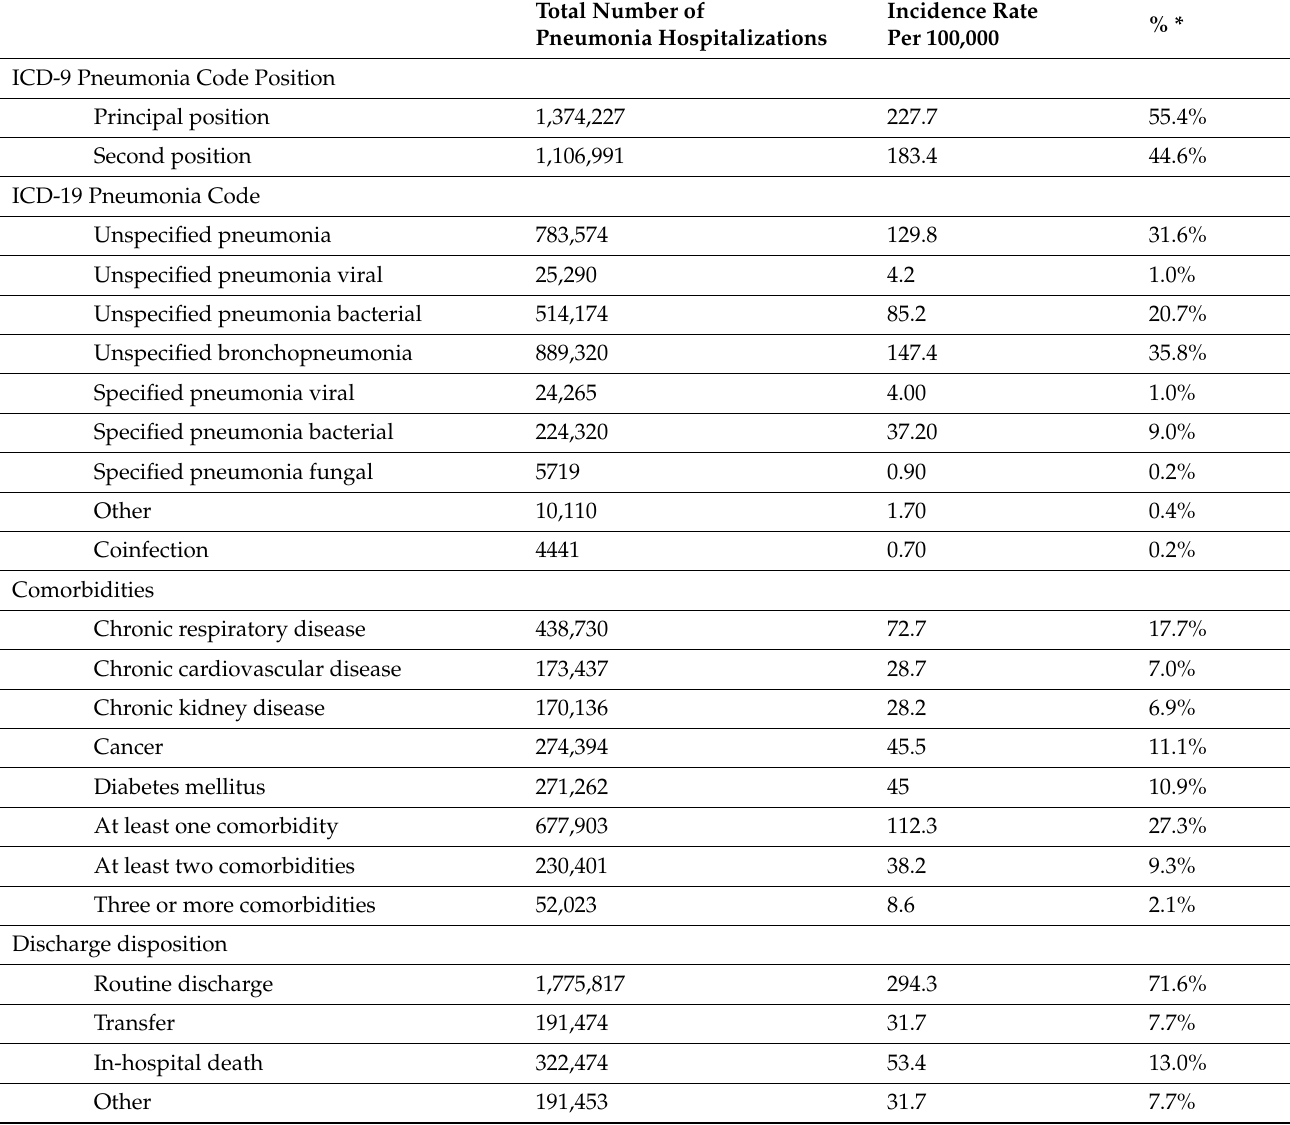
Table 3. Clinical and administrative characteristics of hospitalizations for pneumonia in Italy from 2010 to 2019.